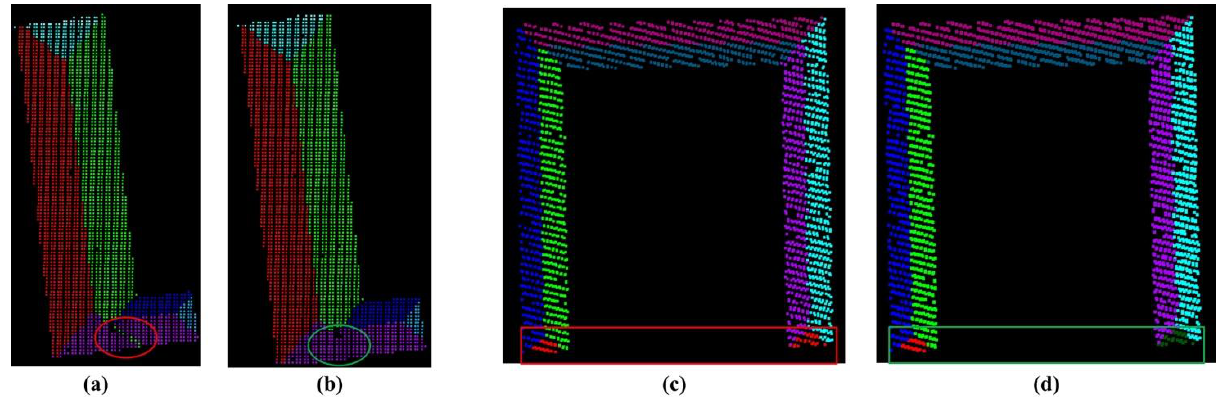
Figure 15. Normal vector consistency validation ( a–b ) and coplanar validation ( c–d